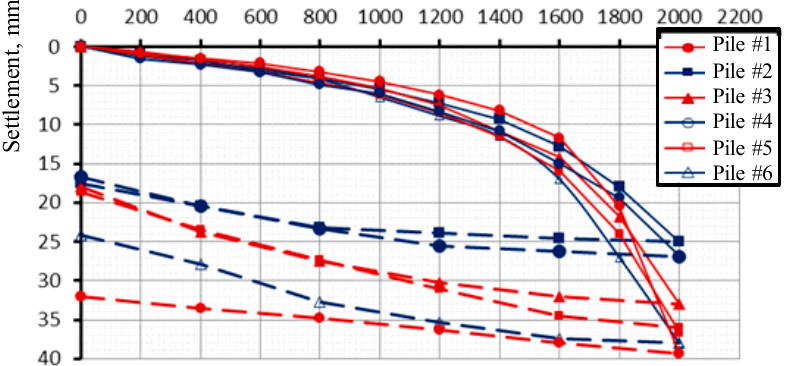
Figure 7. Curve of the correlation of loading P with settlement S according to the results of static tests of piles with a protective shell (without soil wetting).